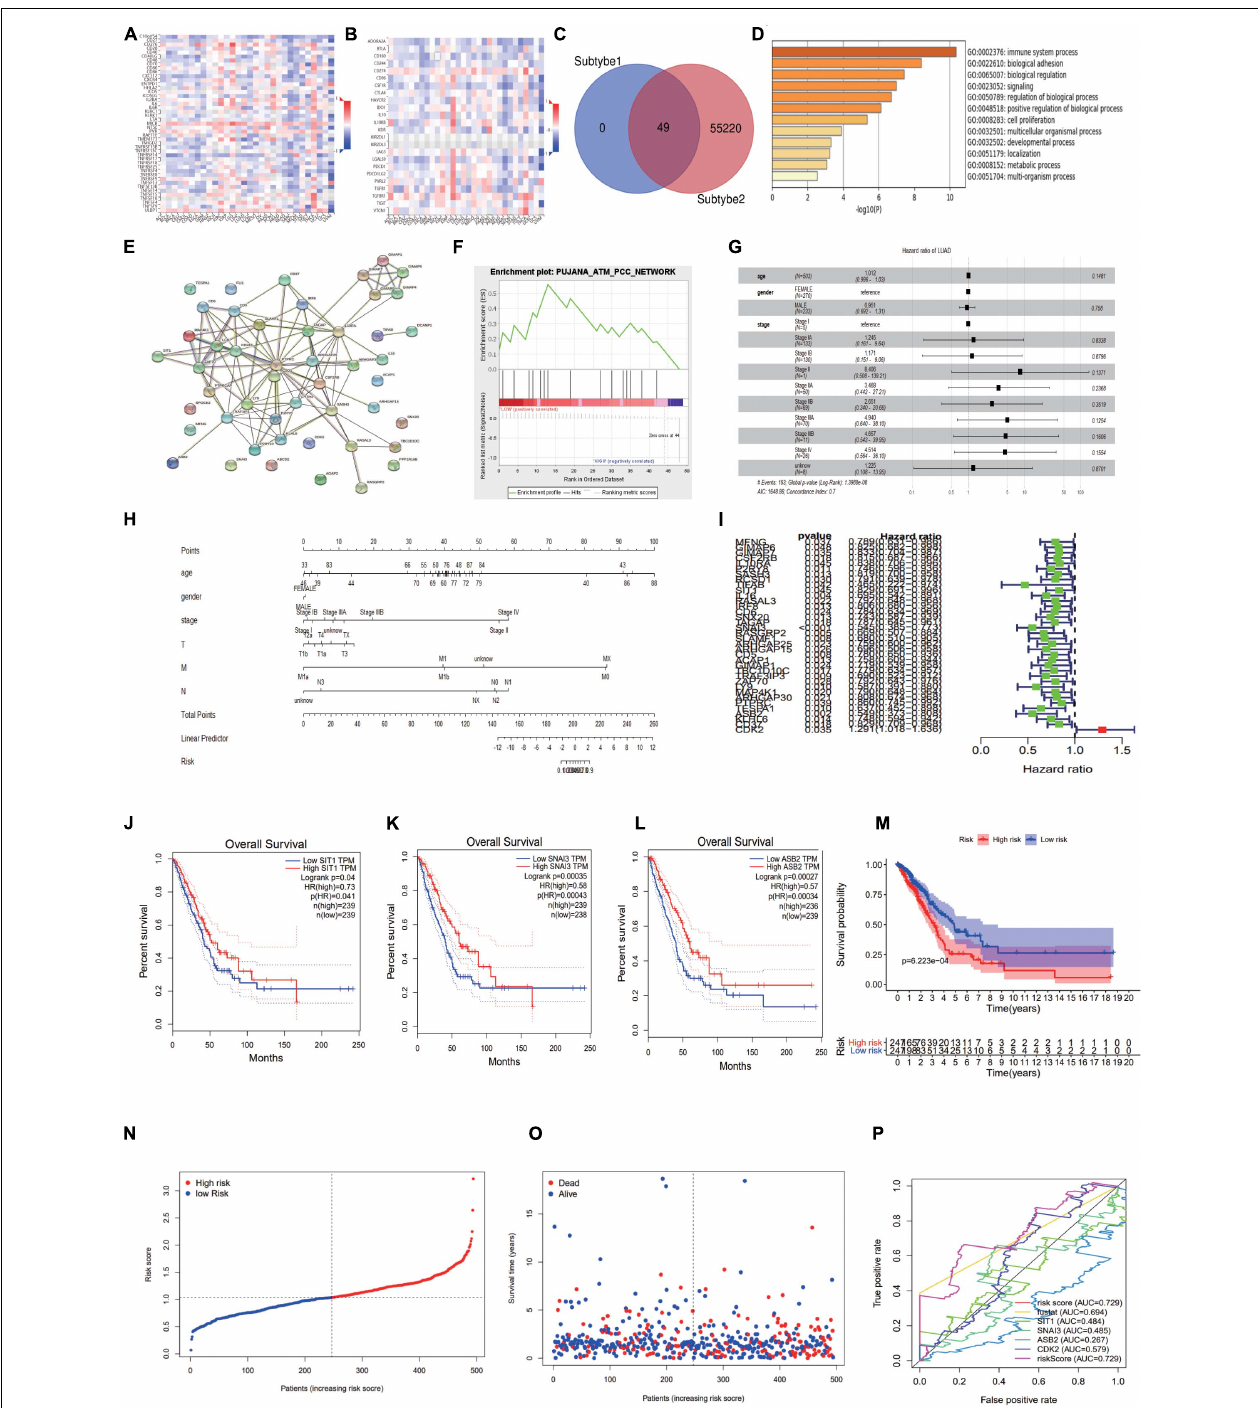
FIGURE 10 | Construction of immune related forecasting model. (A,B) The heat maps of immunopotentiators and immunosuppressants about CDK2. (C) 49 genes were mixed from the TCGA using “perl” and “R” package. (D) The most abundant pathway of 49 genes was immune system process. (E) The protein network interaction of these 49 immune related genes. (F) GSEA analyzed the function, ES, NES, NOM p -val, FDR q -val of 49 genes. (G) The forest map showed Hazard ratio and concordance index (0.7) of LUAD. (H) Nomogram model combined several clinical factors, such as age, gender, stage, T, N, M. (I) We showed the Hazard ratio (HR), HR95L, HR95H, p-value of these 36 significant genes. (J–L) Through the GEPIA database, SIT1, SNAI3, ASB2 were lower expressed in LUAD. (M) The risk curve showed that the high-risk group was more lethal to lung cancer patients. (N,O) The high and low risk maps. (P) The ROC curve showed the different AUC of four interesting